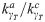
Comparison of internal nutrient-dependent regulation of transporter synthesis and activity-dependent transporter downregulation.For different normalized concentrations of Sext, the values of n and kγTa/kγTc required to achieve either 0.8 or 0.95 robustness (blue curve and black curve respectively) are plotted. Four different specific normalized Sext values are represented by the four colored dots. We assumed nutrient uptake per transporter was Michaelian u(Sext)=SextSext+Kext.